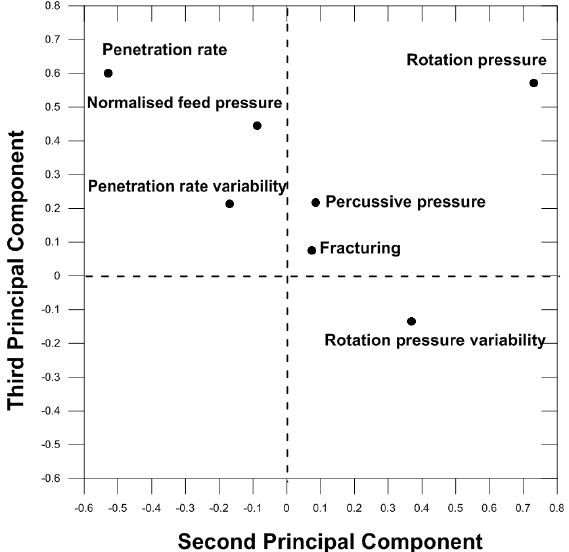
Figure 14. Loading plot for second and third principal components.